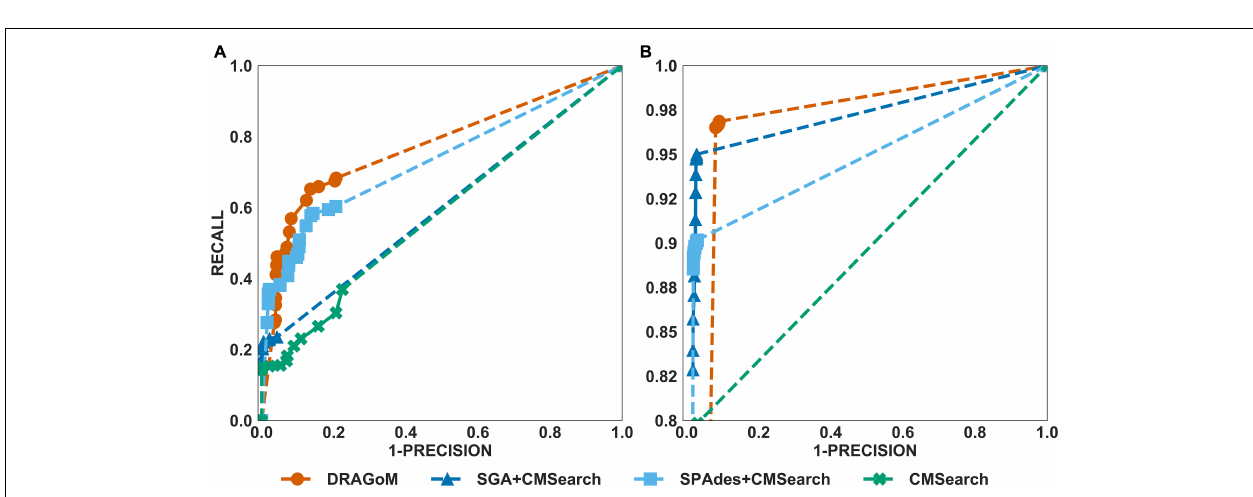
FIGURE 4 | The ROC curves for searching (A) 93 non-16S rRNAncRNA families and (B) 16S rRNAs using the corresponding programs against DS3 (the simulated marine dataset).